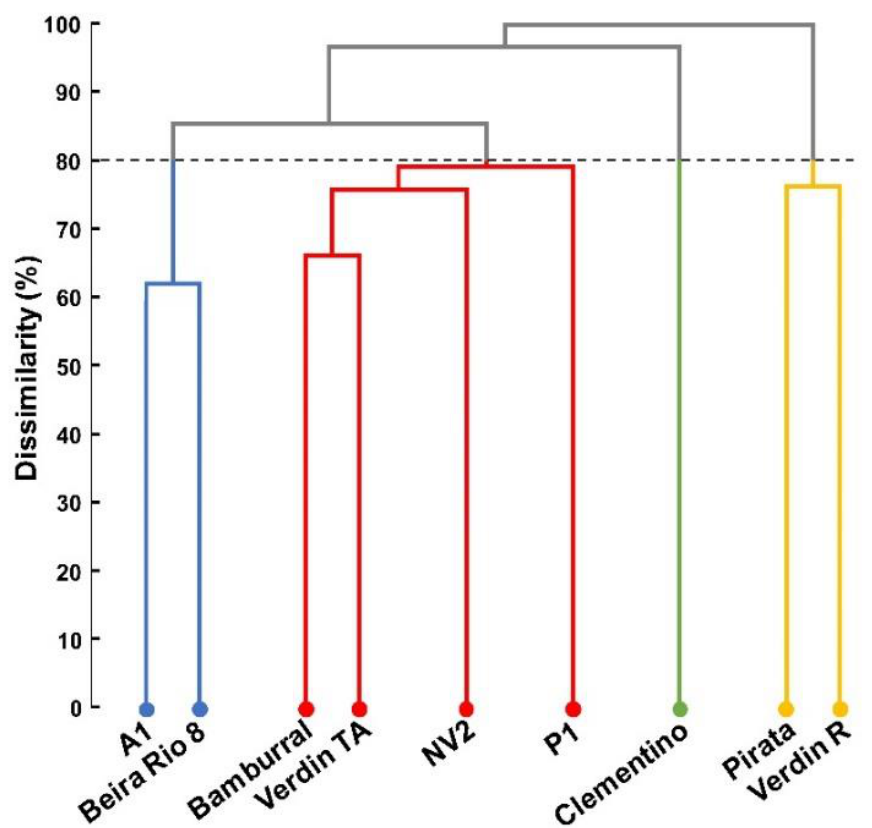
Figure 4. Dendrogram representing the dissimilarity between 9 genotypes of Coffea canephora , obtained by the UPGMA clustering method with Euclidean distance, considering the concentration of nutrients in flowers, grains, straws, and leaves. The genotypes A1 and Beira Rio 8 formed the first group; Bamburral, Verdin TA, NV2, and P1 formed the second; Clementino was the third; Pirata and Verdin R formed the fourth. The formation of groups, considered divergent between themselves, indicates the variability between the genotypes of C. canephora for the concentration of nutrients evaluated.